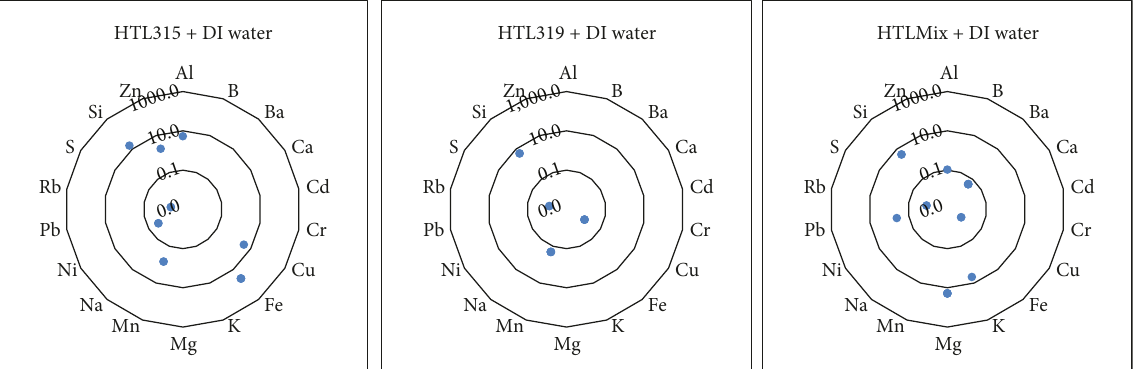
Figure 4: Common elemental composition (in ppm) of each leachate reacted with deionised water at 70 ° C temperature under 1bar pressure in batch rotating shakers after 670 hours (absence of data points re fl ects concentrations below the limits of detection).